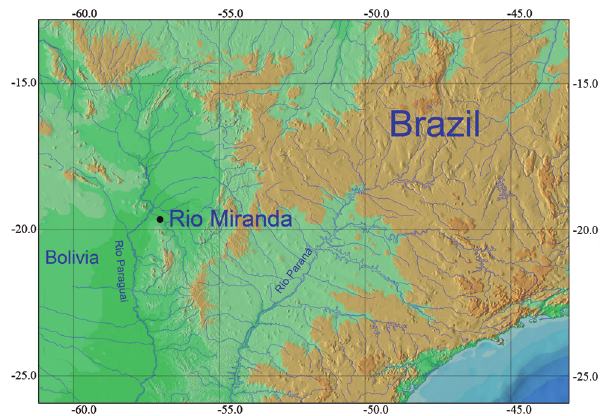
Fig. 1. Collection sites of Pimelodella specimens (black circle, 19°34’37”S and 57°00' 42”W) in the Miranda River basin, Passo do Lontra, Mato Grosso do Sul State,